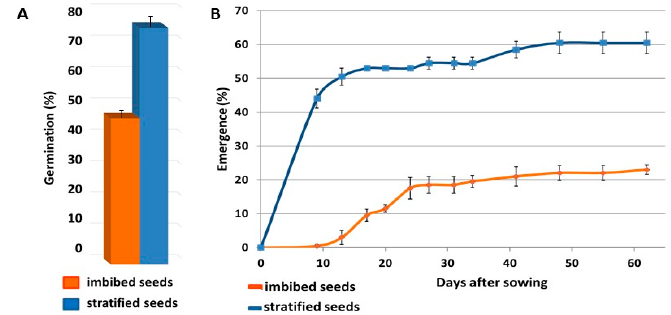
Figure 2. Germination and emergence of imbibed and stratified A. sativum seeds. Seeds from the July 2016 harvest were either imbibed for eight hours or stratified at 4 °C for eight weeks. Bars represent Standard eror (SE) ( A ) Germination percentage in Petri dishes after 50 days at 20 °C in dark. n = 2 (20 seeds/replicate). ( B ) Emergence rate in growing boxes during the first 60 days after sowing. n = 2 (200 seeds/replicate).